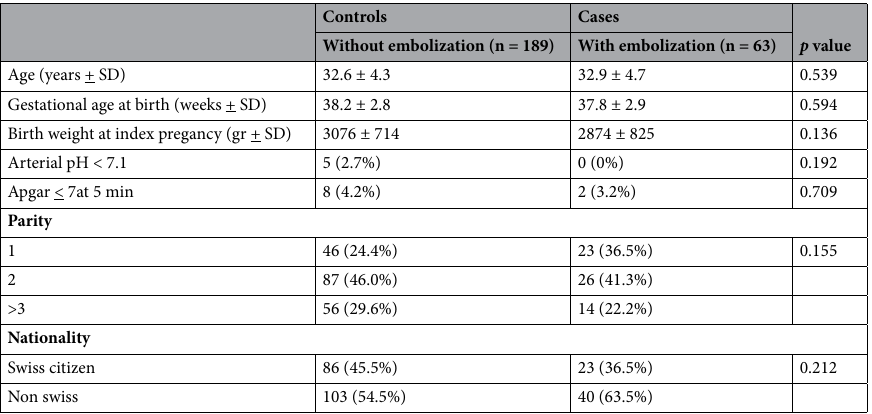
Table 1. socio-demographic characteristics at the index delivery (SD: standard deveiation; min: minutes).